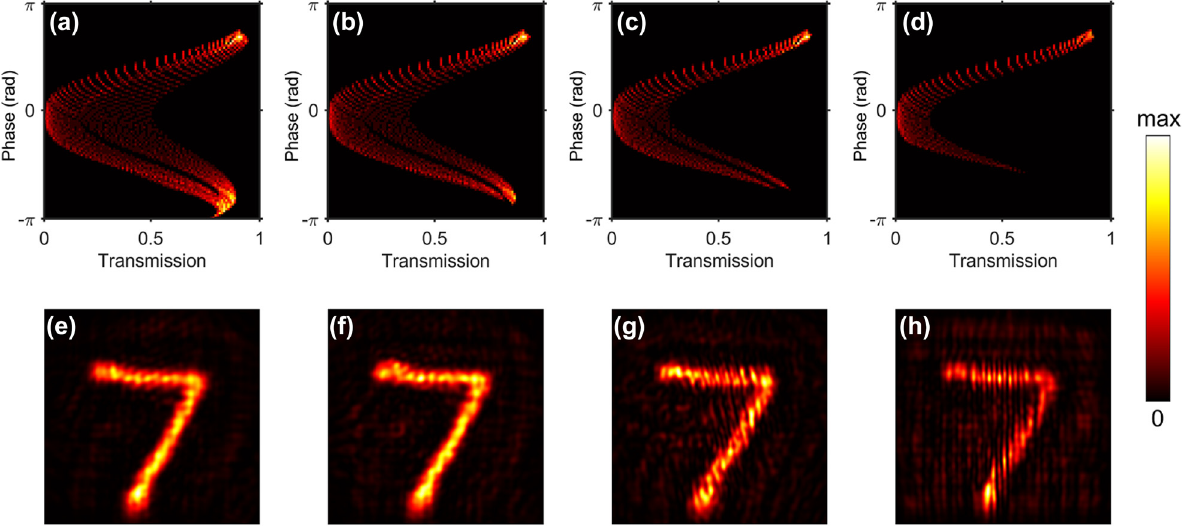
Figure 7: Capacity maps for phase and transmission modulation with varying ranges of the design parameters. The regions that lack the control of light is shown in black and get enlarged when the parameter ranges become narrower. (a)300 – 470nmfordiameter&580 – 700nmforheightthathavebeenadoptedinthesectionofMethods.(b)300 – 450nmfordiameter&580 – 680 nm for height. (c) 300 – 430 nm for diameter & 580 – 660 nm for height. (d) 300 – 410 nm for diameter & 580 – 640 nm for height. (e) – (h) Reconstructive images corresponding to (a) –